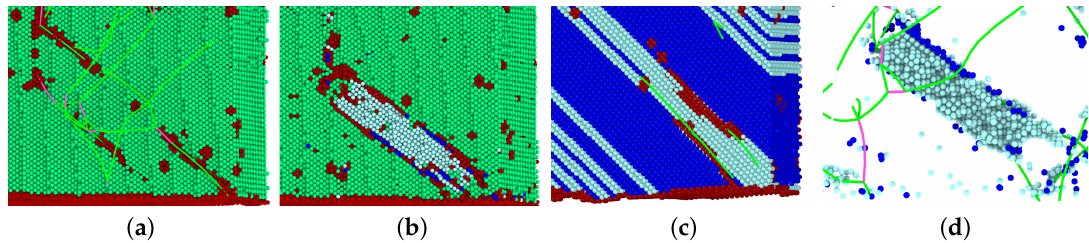
Figure 5. Snapshots of a bcc sample with high dislocation density, ρ = 4.5 × 10 12 cm − 2 , ( a ) before, ( b ) at the start, and ( c ) after the austenitic transformation at temperatures of 543, 753, and 1250 K, respectively. Snapshots show a view on a ( 110 ) bcc plane; ( d ) a perspective view of the dislocation structure in ( b ). The colors denote the local lattice structure and the dislocations (in the bcc-phase) as in Figure 1.